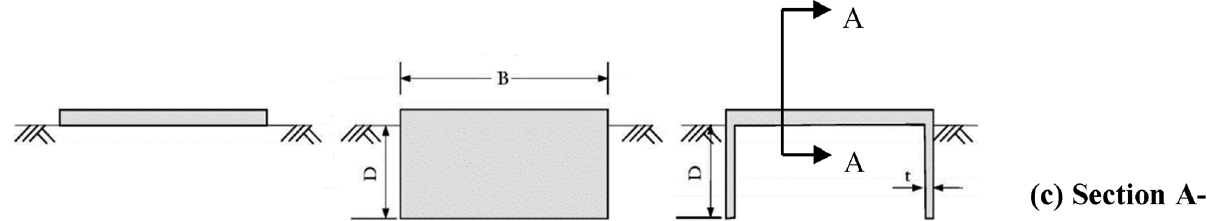
Figure 1: Schematic diagram of skirted footing [ 4 ] .